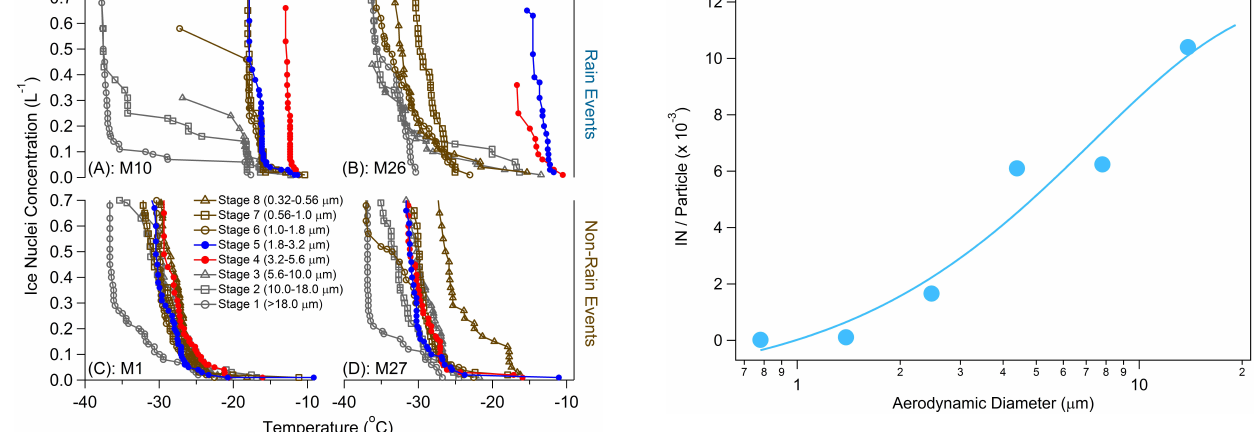
Fig. 6. An estimate of the fraction of particles collected during rain events (M10, M26) that can serve as IN at − 15 ◦ C. IN concentra- tions were calculated from microscopic IN activation experiments and particle concentrations were calculated from UV-APS measure- ments. See SOM Sect. S1.4.1.1 for sampling dates. Note that the fraction of particles with IN activity is greater than 1 in 1000 for all particles > 2µm and exceeds 1 in 100 for particles > 10µm. Expo- nential curve shown to guide the